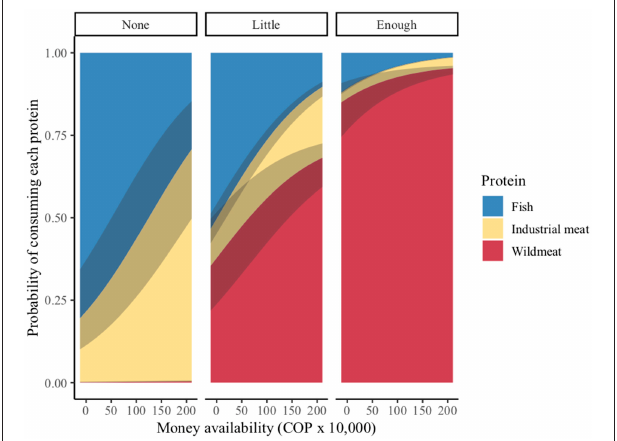
FIGURE 8 | Protein consumption model. The colored areas correspond to the probability of choosing each protein type depending on the amount of money available. The gray areas are the confidence intervals for wildmeat and for industrial meat (fish is the reference level and therefore confidence intervals are not